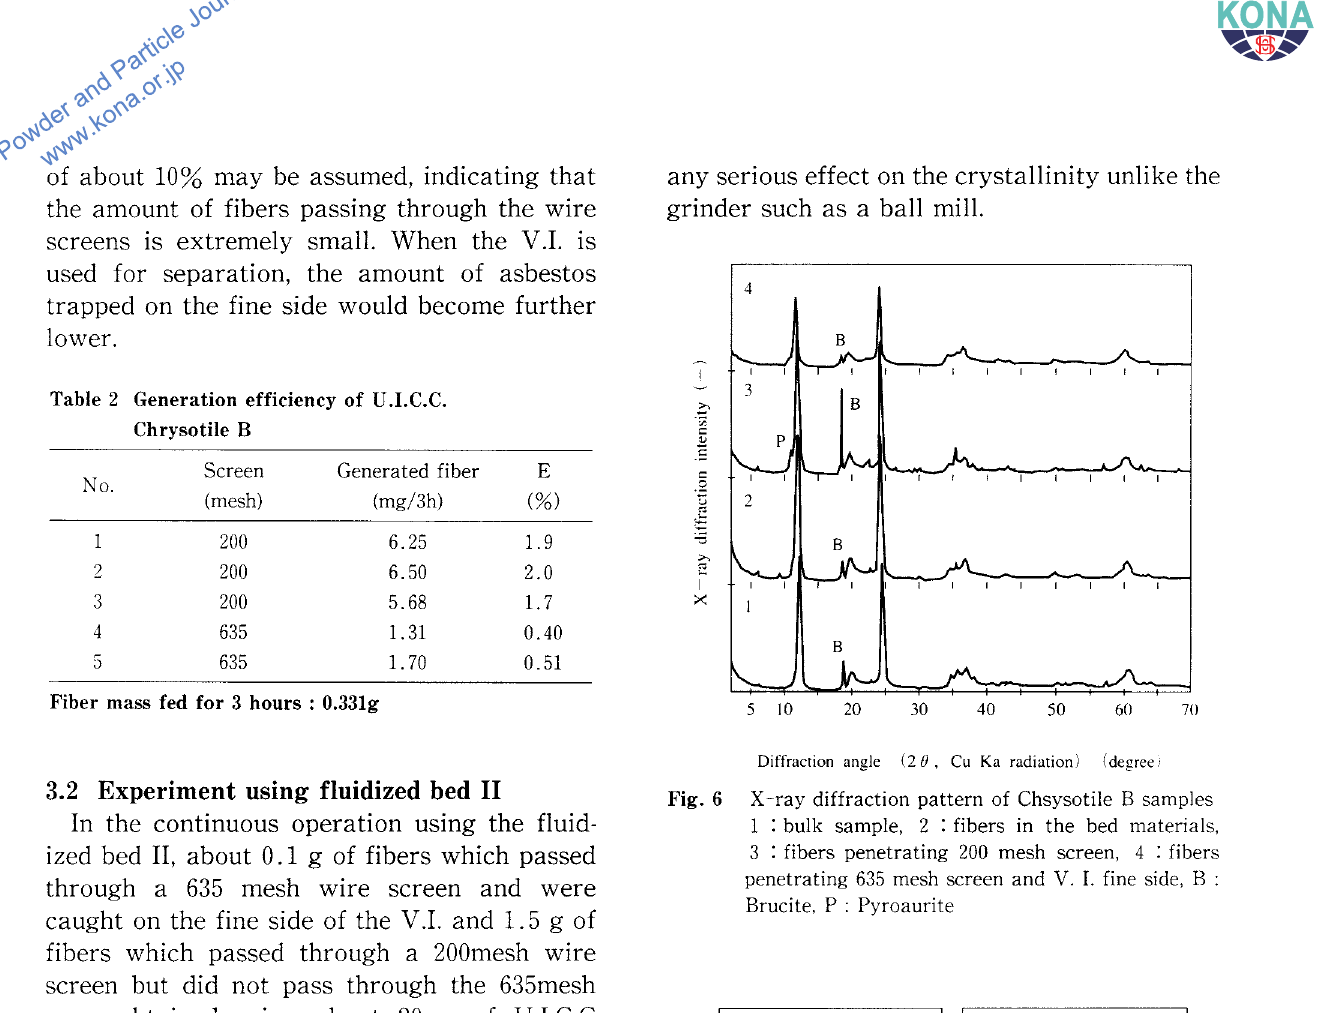
Table 2 Generation efficiency of U.I.C.C.